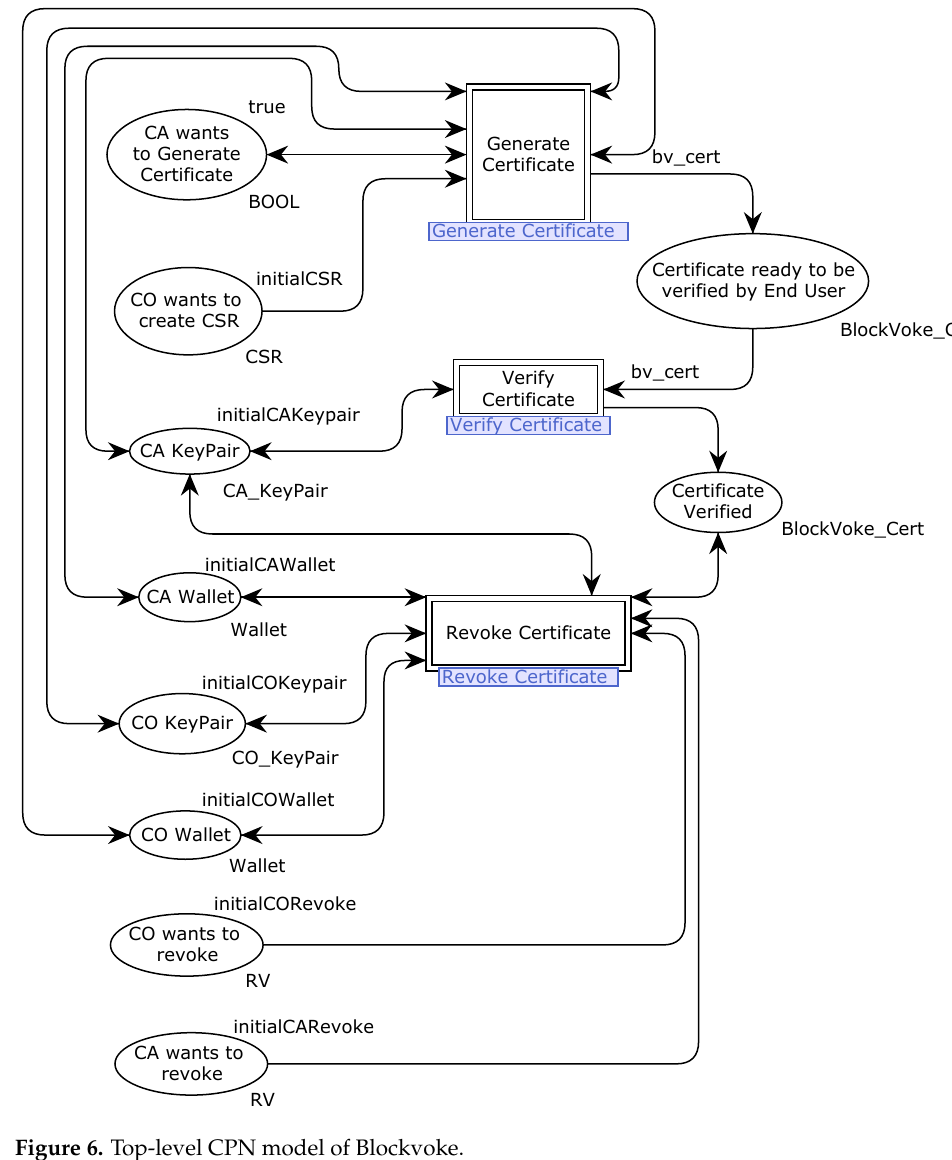
Figure 6. Top-level CPN model of Blockvoke.